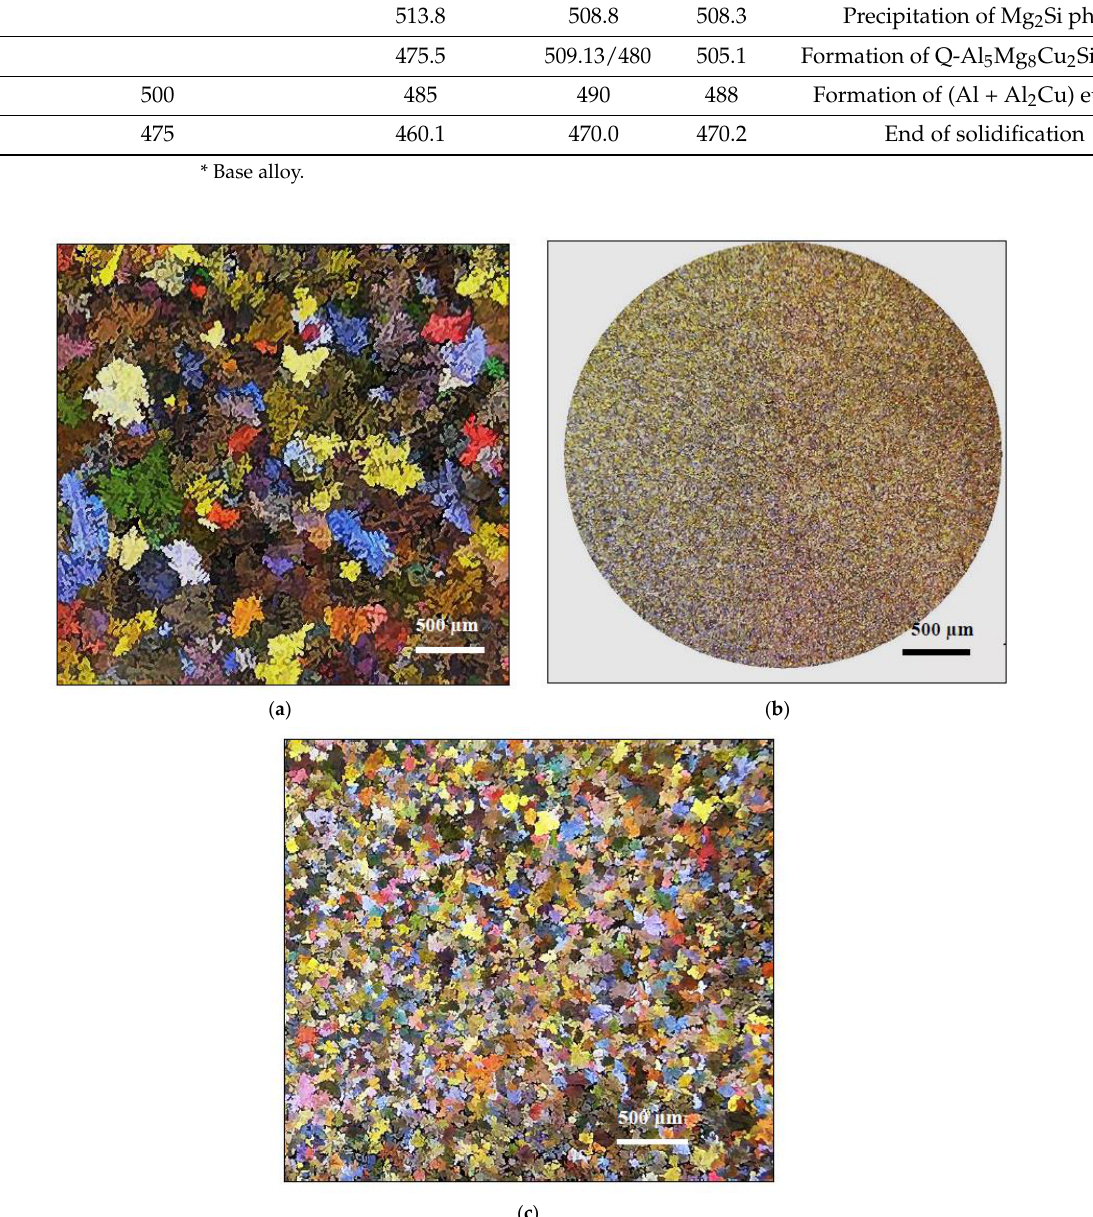
Figure 6. Macrostructure showing grain size in samples sectioned from ( a ) thermal analysis casting, ( b ) die casting, and ( c ) thermal analysis sample grain refined with 0.15% Ti (added as Al – 5%Ti – 1%B master alloy to alloy A).